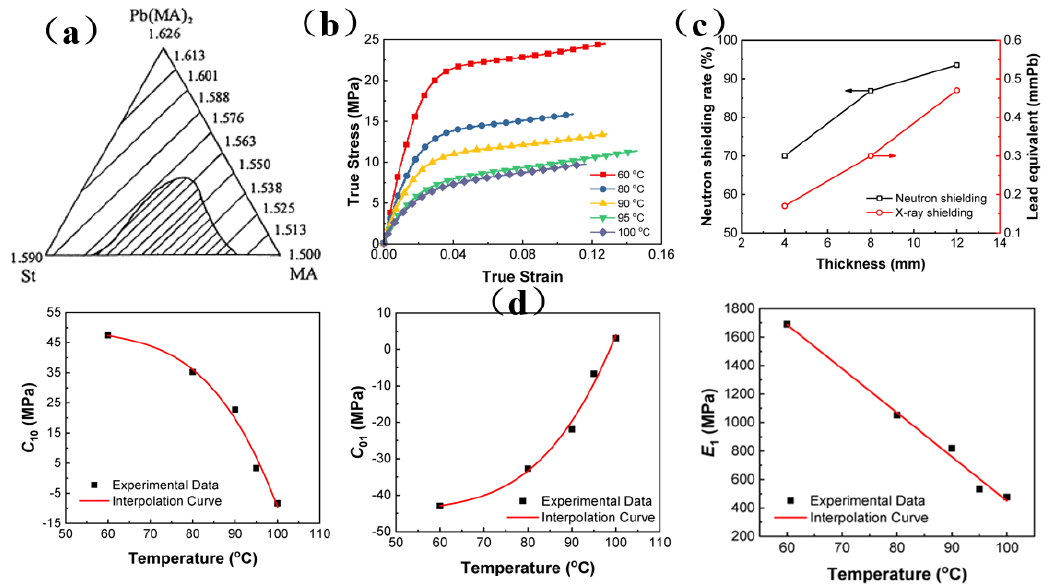
Figure 11. ( a ) Polymer − transparent phase diagram of Pb(MA) 2 /St/MA ternary copolymerization system with the same refractive index line (shaded areas are transparent areas) [121]. Copyright 2000, MDPI. ( b ) The stress − strain curves of Gb/Pb acrylate at various temperatures under the same stretching rate of 1.667 × 10 − 4 s − 1 [33]. Copyright 2022, MDPI. ( c ) The radiation shielding performance of metallized acrylic polymer was evaluated by lead equivalent thickness [33]. Copyright 2022, MDPI. ( d ) The variation law of model parameters with temperature and interpolation curves. (b, c, d) [33]. Copyright 2022, MDPI.